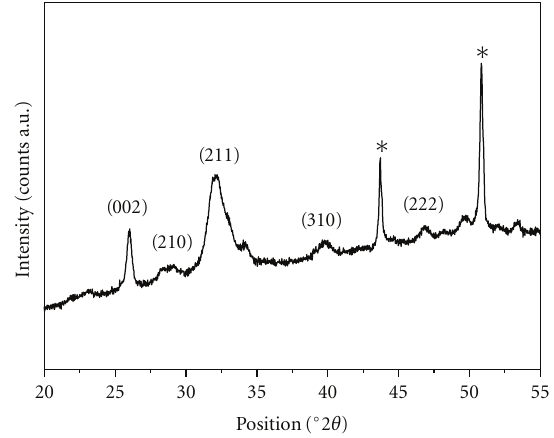
Figure 6: FT-IR spectra of electrospun pure collagen (red) and collagen-hydroxyapatite composite (black) in the region 1800– 700 cm − 1